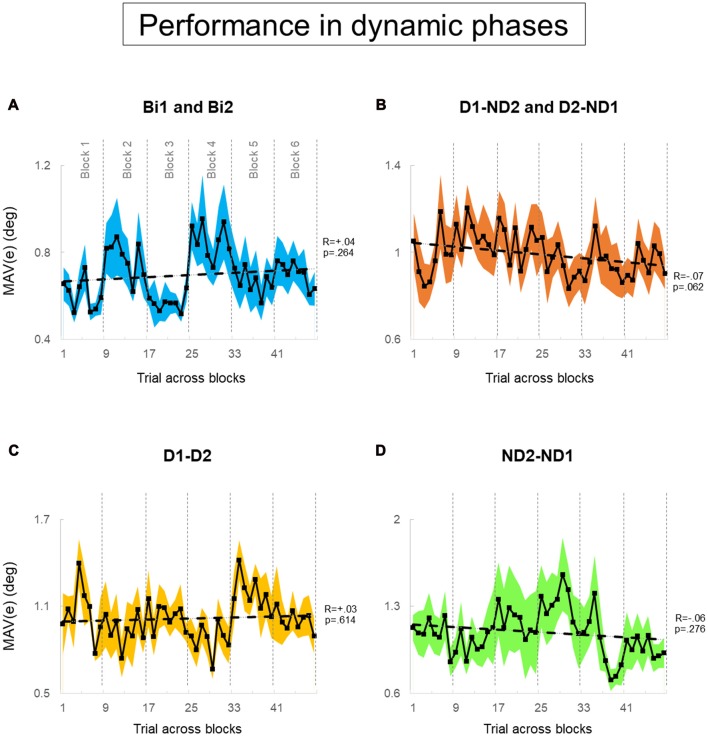
Performance error of dynamic phase. (A–D) MAV(e) across trials and blocks for bimanual conditions, dominant and non-dominant hand conditions, both dominant hand condition, and both non-dominant hand condition; respectively. There are six blocks, and each block consists of eight trials. We tested 12 subjects and 12 pairs for each block in (A,B), respectively. We tested six dyads for each block in (C,D). Data are means averaged across all subjects or pairs. The shaded area around the main plot denote standard errors of the mean. The dash line plotted is the best fitted regression to test whether there is a significant trend for MAV(e) across trials and blocks.